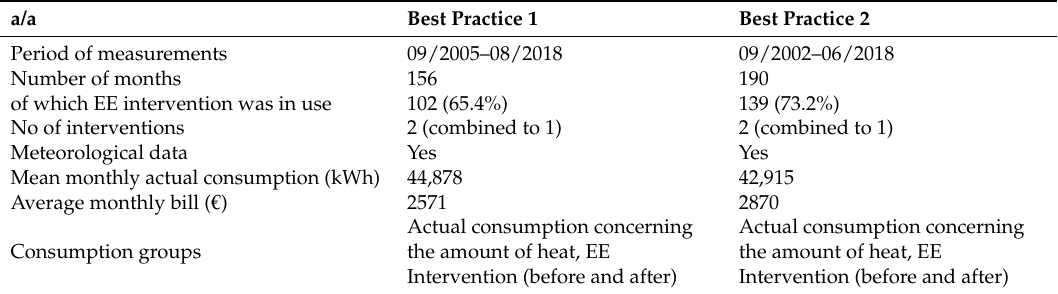
Table 1. Highlights of SEV’s dataset.